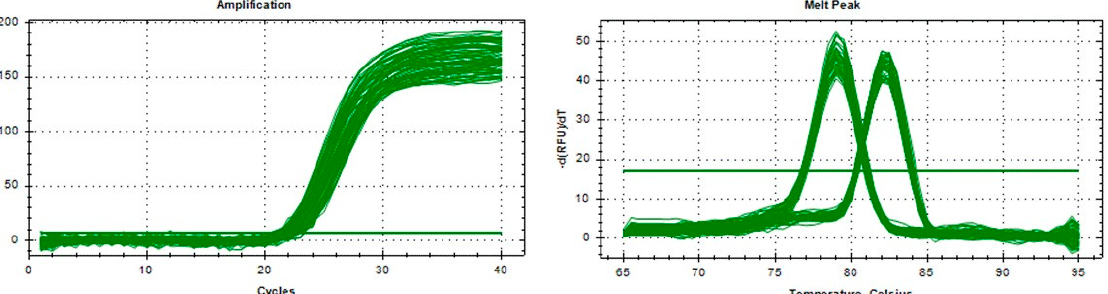
Figure 3. The specific primers of the SHE gene and the ANKRD1 gene.